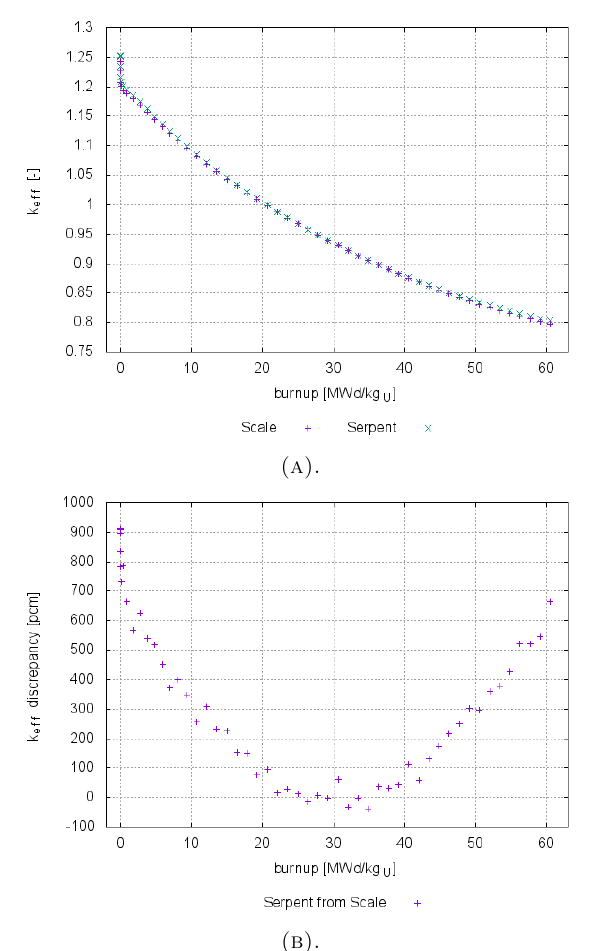
Figure 2. Multiplication factor from SCALE and Serpent calculation (a) and SCALE difference from Serpent results